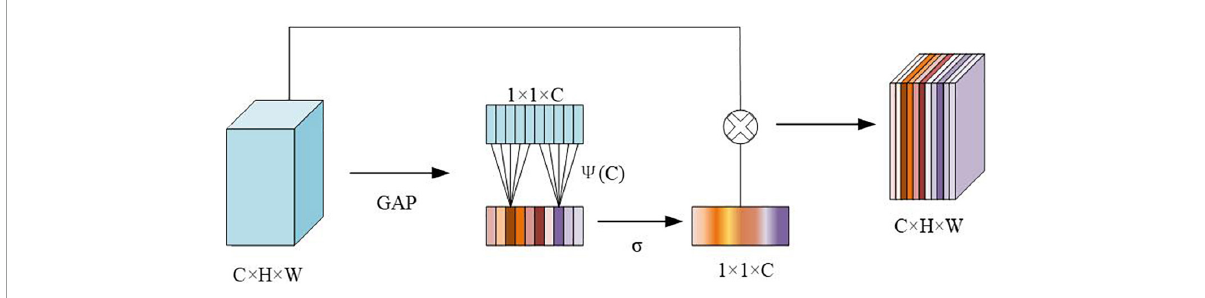
FIGURE4 Structure of efficient channel attention (ECA)